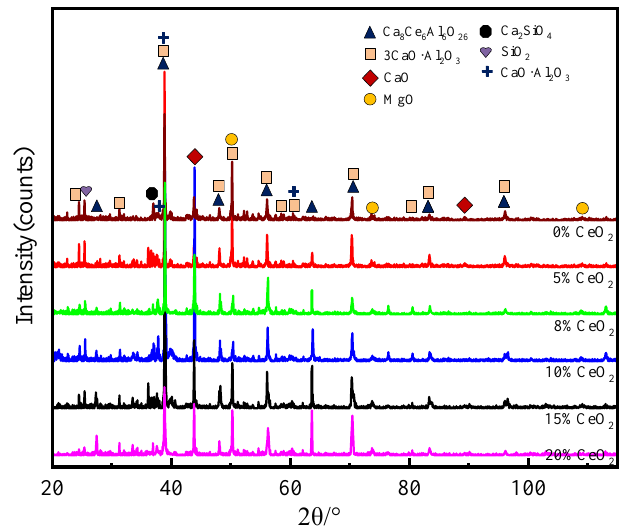
Figure 3. Ca 8 Ce 6 Al 6 O 26 structure compositions.